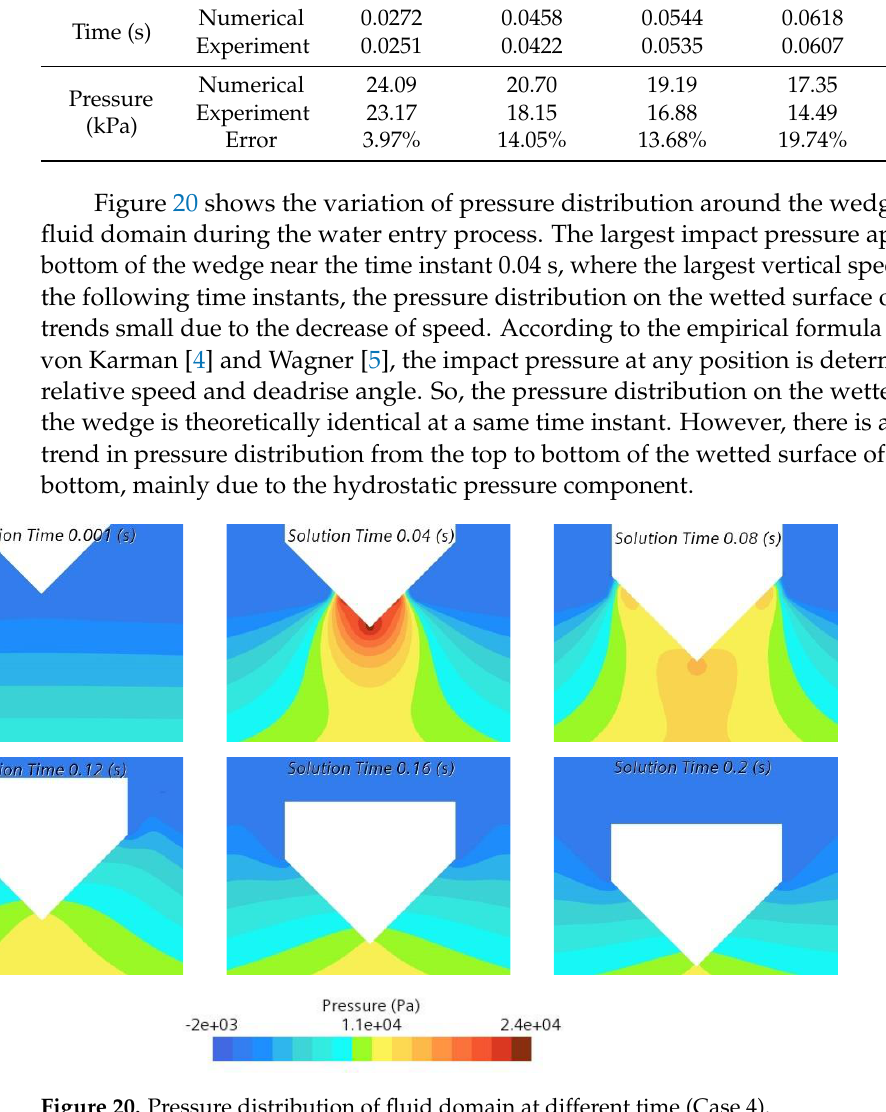
( b ) Figure 21. Structural stress at points S1 – 3 (Case 4): ( a ) time series; ( b ) frequency spectra. Moreover, the vertical acceleration at bottom points S1 – 3 during the water entry pro- cess is shown in Figure 22a,b. It is seen that in the time series, the high-frequency vibra- tions are very pronounced initially, which is probably caused by numerical dispersion. Then, the acceleration tends to be steady, and small amplitude whipping loads are super- posed on the low-frequency signal. As seen from the spectra, there exist several peaks,